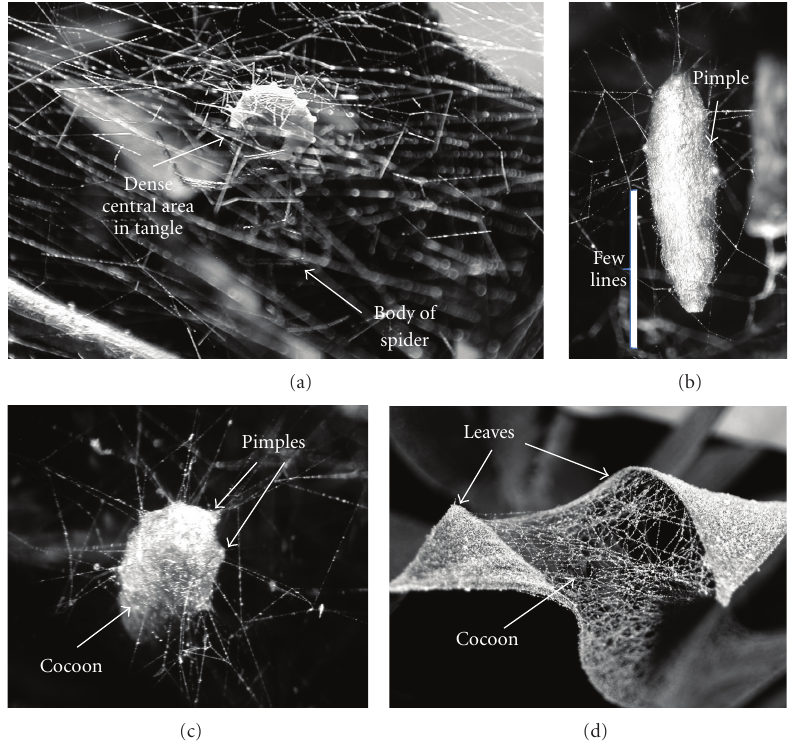
Figure 2: Cocoon web of A . nr. studiosus (a) in which the wasp larva holds onto the densely-meshed central area just after having discarded the corpse of the spider. Lateral (b) and dorsal (c) views of wasp cocoons in cocoon webs of A. octavius , showing the radial pattern of lines around the upper end of the cocoon (c), and that the lines intersecting the cocoon (indicated by small “pimples”) are in the upper portion of the cocoon, with an open space below in which the cocoon hangs free (bar in (b)). The cocoon web spun from scratch in captivity (d) incorporated flat leaves (covered with white dust in the photo) as parts of the